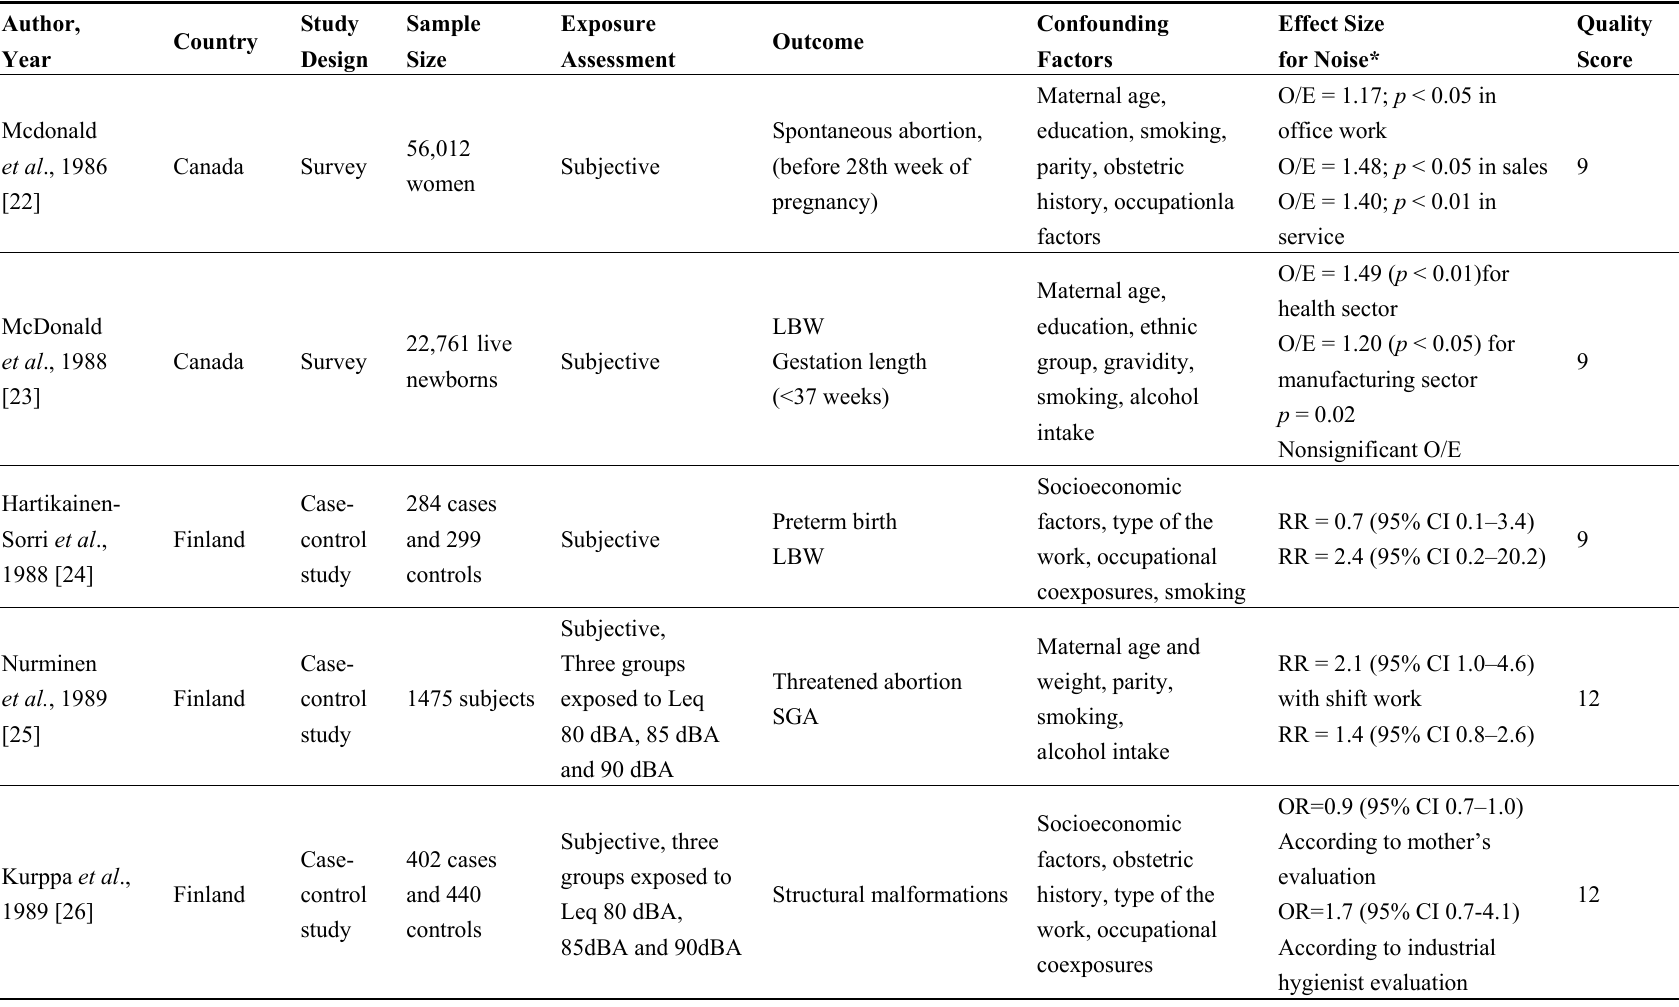
Table 1. Summary of epidemiological studies of occupational noise exposure and reproductive outcomes (ordered by year of